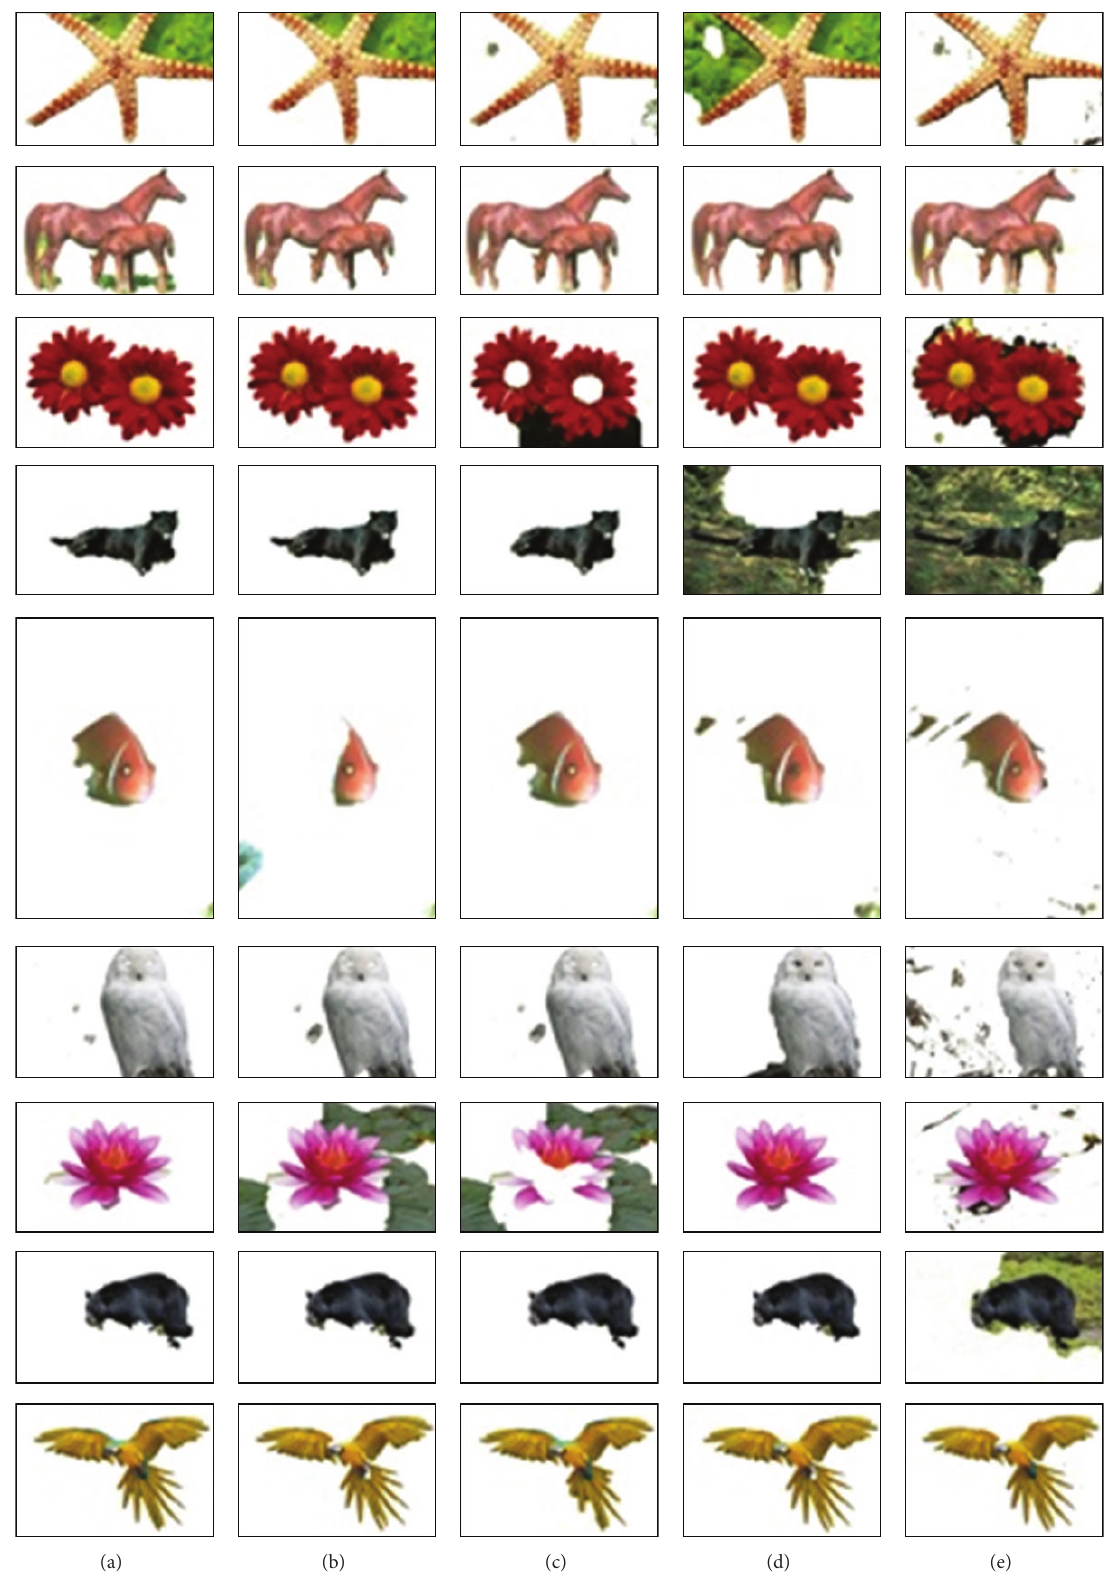
Figure 5: Visual comparison of segmentation results for automatic GrabCut applied in the (a) 𝑅𝐺𝐵 , (b) 𝑌𝑈𝑉 , (c) 𝑋𝑌𝑍 , (d) 𝐶𝑀𝑌 , and (e) 𝐻𝑆𝑉 color